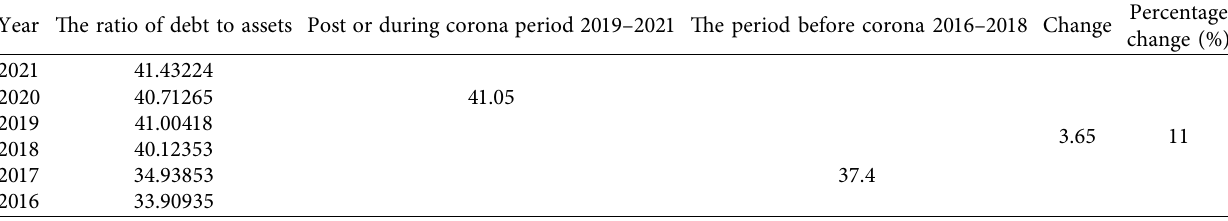
Table 8: Te evolution of the debt-to-asset ratio of the study sample before and after the efects of the Corona delinquency. Year Te ratio of debt to assets Post or during corona period 2019–2021 Te period before corona 2016–2018 Change